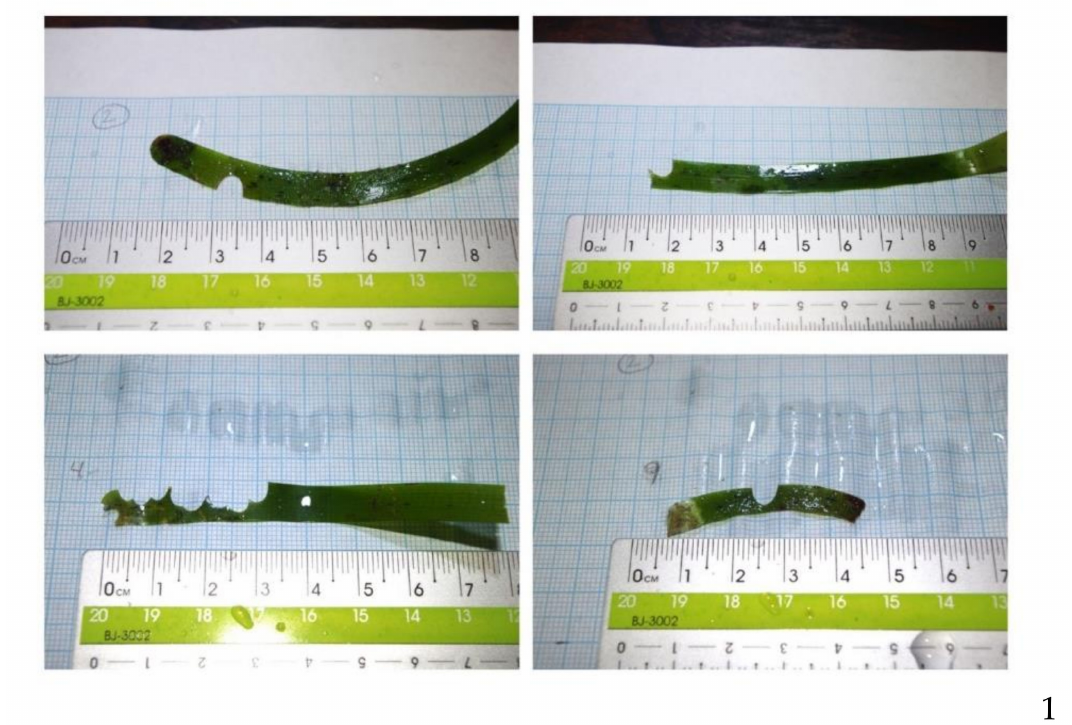
Figure A6. Bite marks of L. vaigiensis on seagrass leaves.